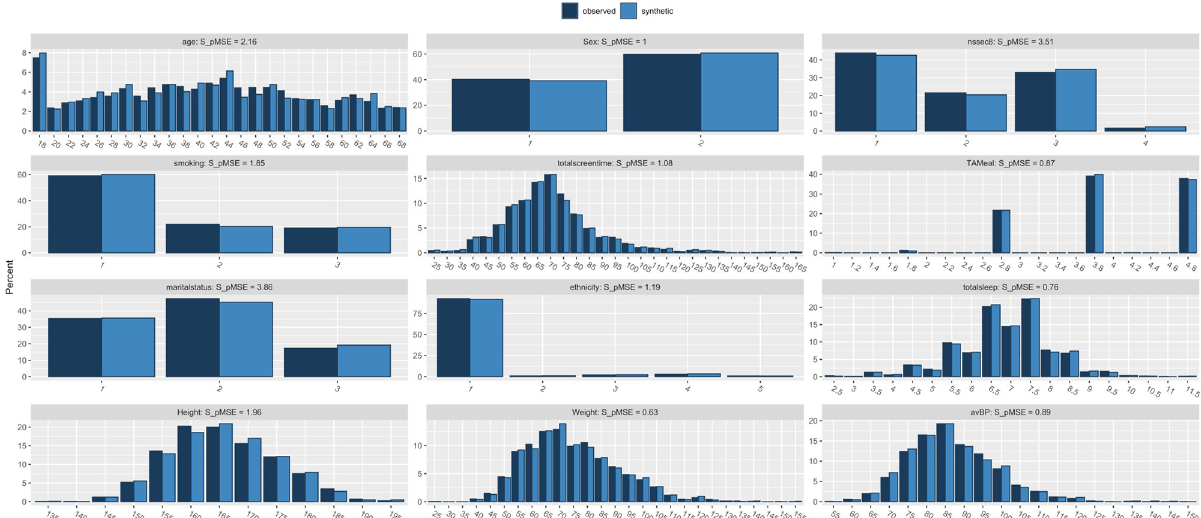
Fig 1. Histogram comparison for each variable comparing the aggregate demographic characteristics of the real training dataset (n = 2408) against synthetic dataset A (n = 2408).